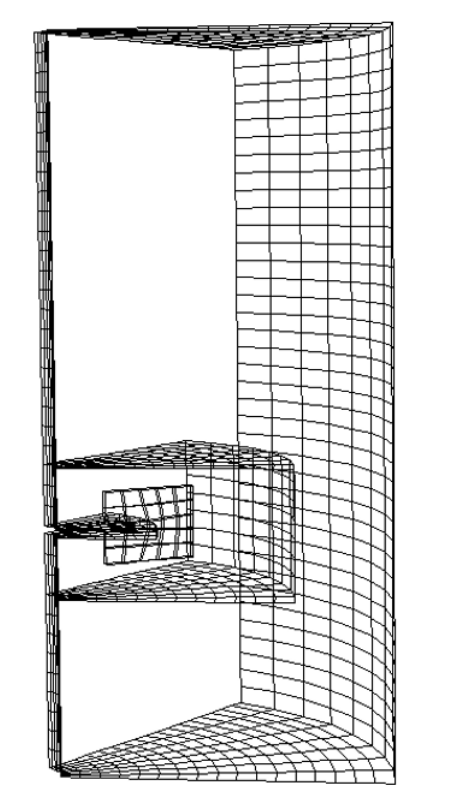
Figure 2. Subdivision of the computational